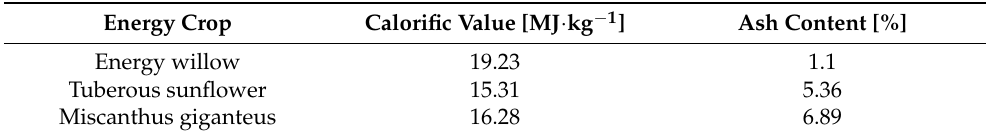
Table 1. Energy crop parameters